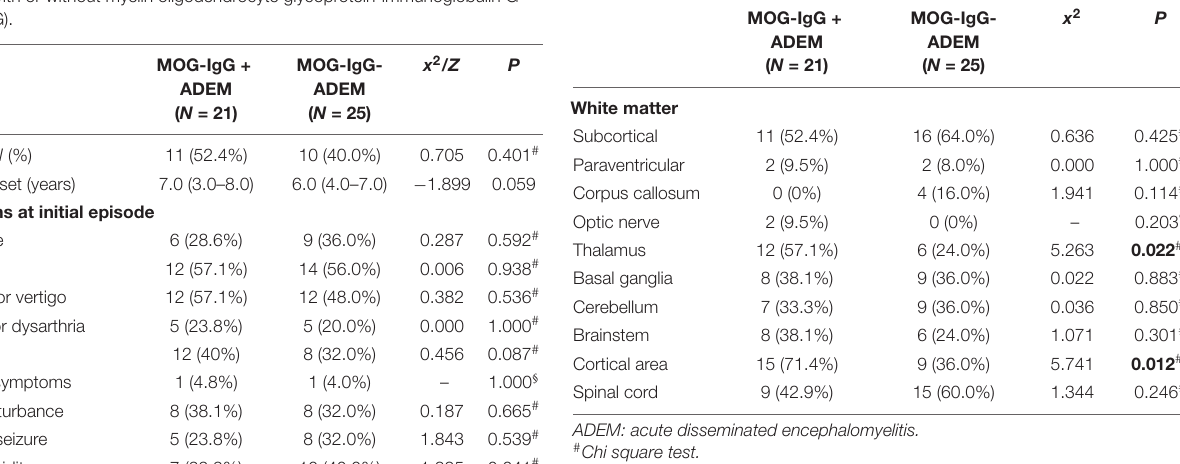
TABLE 3 | Presence of the lesion in specific areas of the brain and spinal